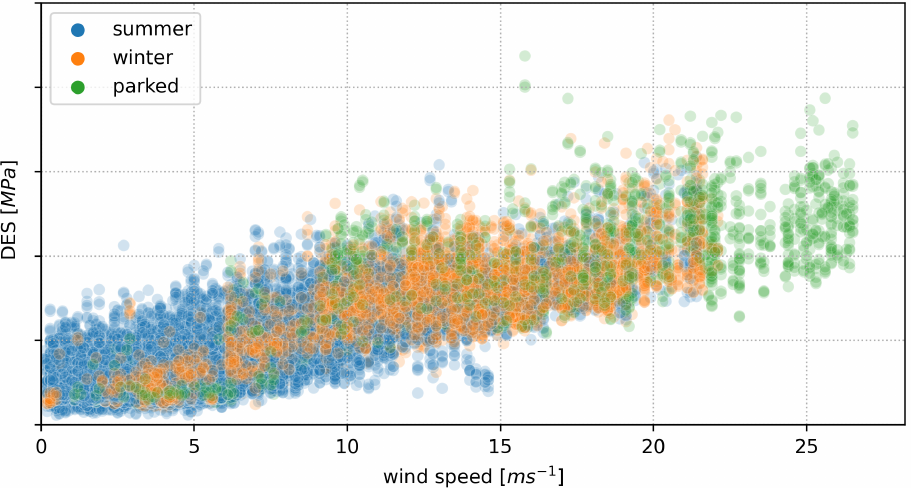
Figure 11. Damage equivalent stress range (DES) of measurements from all sensors and validations sets combined over wind